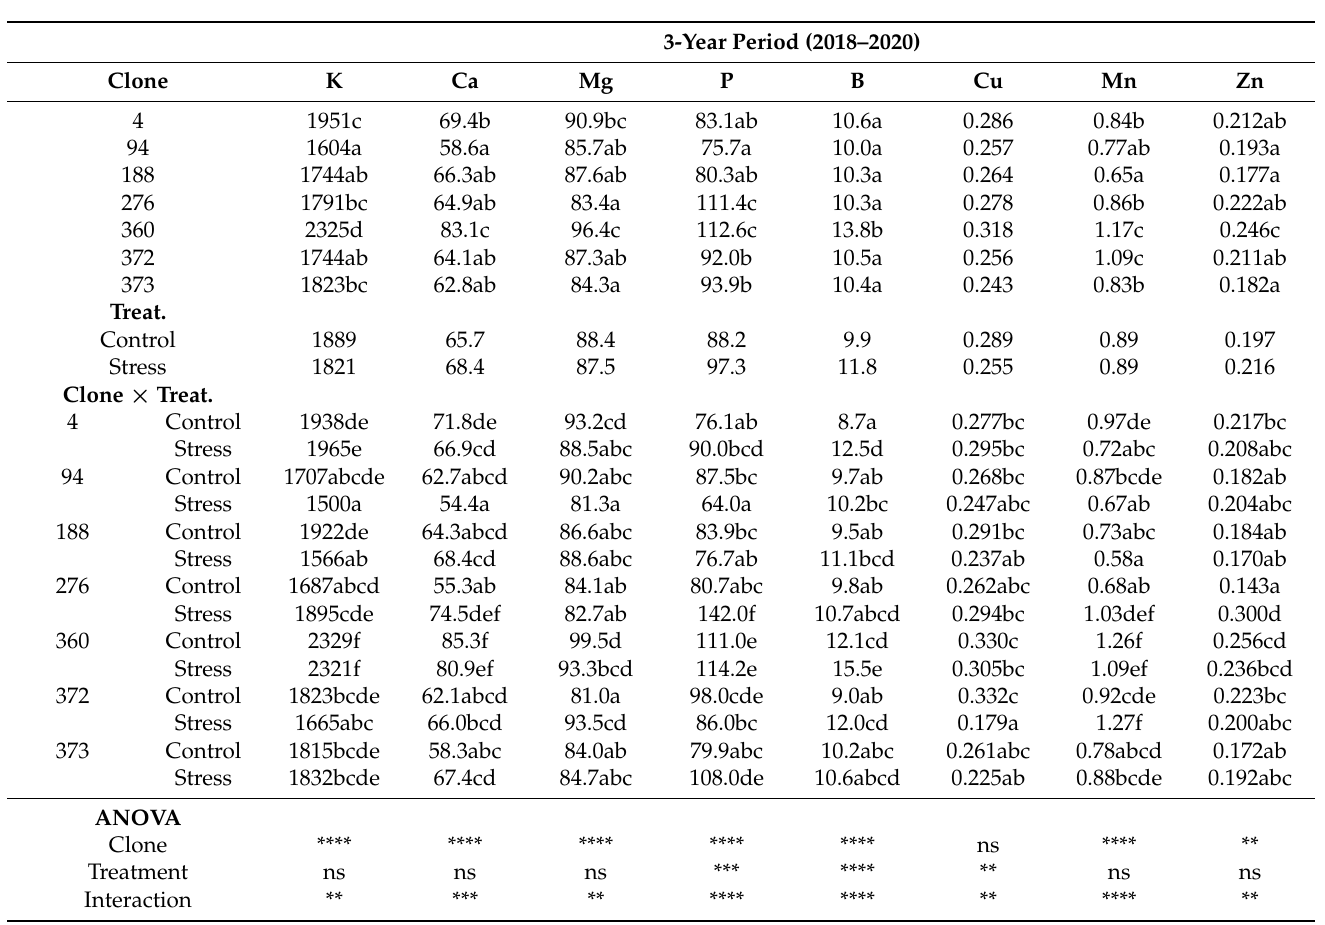
Table 9. Average annual values of mineral composition of must at harvest for each clone, irrigation treatment, and the interaction (clones × irrigation treatment) during the 3-year period 2018–2020. Data are expressed as mg L − 1